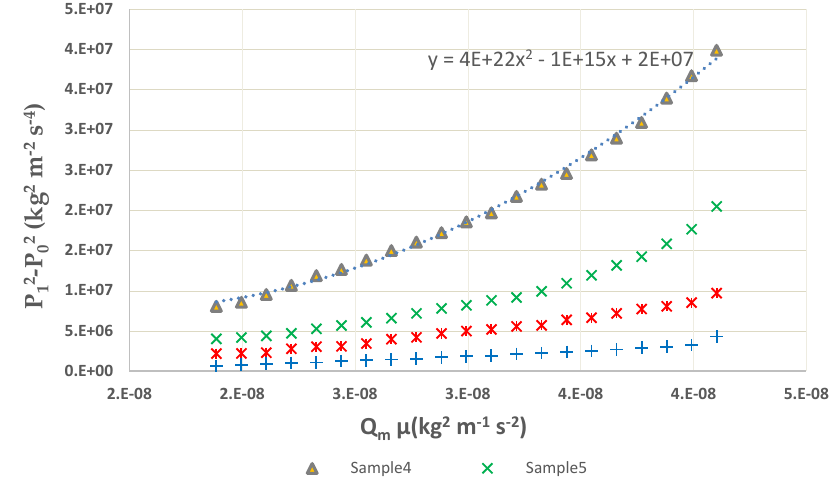
Figure 4. Nonlinearity of Darcy flow check of the samples 4, 5, and 6.